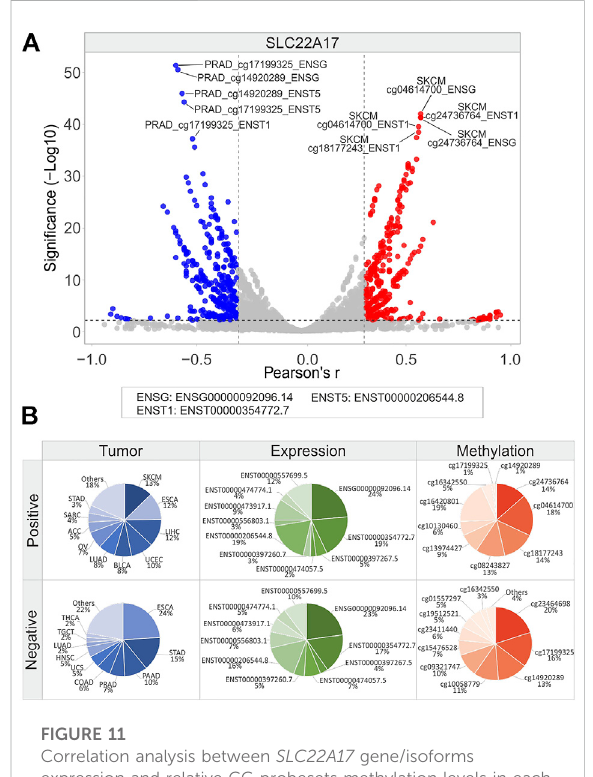
FIGURE 11 Correlation analysis between SLC22A17 gene/isoforms expression and relative CG probesets methylation levels in each tumor type. (A) Volcano plot showing the correlation between CG probesets and gene/isoforms expression of SLC22A17 (Pearson ’ sr ≥ 0.3and ≤ − 0.3, p ≤ 0.01).Thetoptenhits( fi vepositive and fi ve negative) based on correlation signi fi cance are labeled. Blue dots: negative correlation, red dots: positive correlation. (B) Percentage of tumor types, gene/isoforms and CG probesets showing Pearson ’ s r ≥ 0.3 and ≤ − 0.3 ( p ≤ 0.01), separately. No more than ten variables with the highest correlation values are indicated.